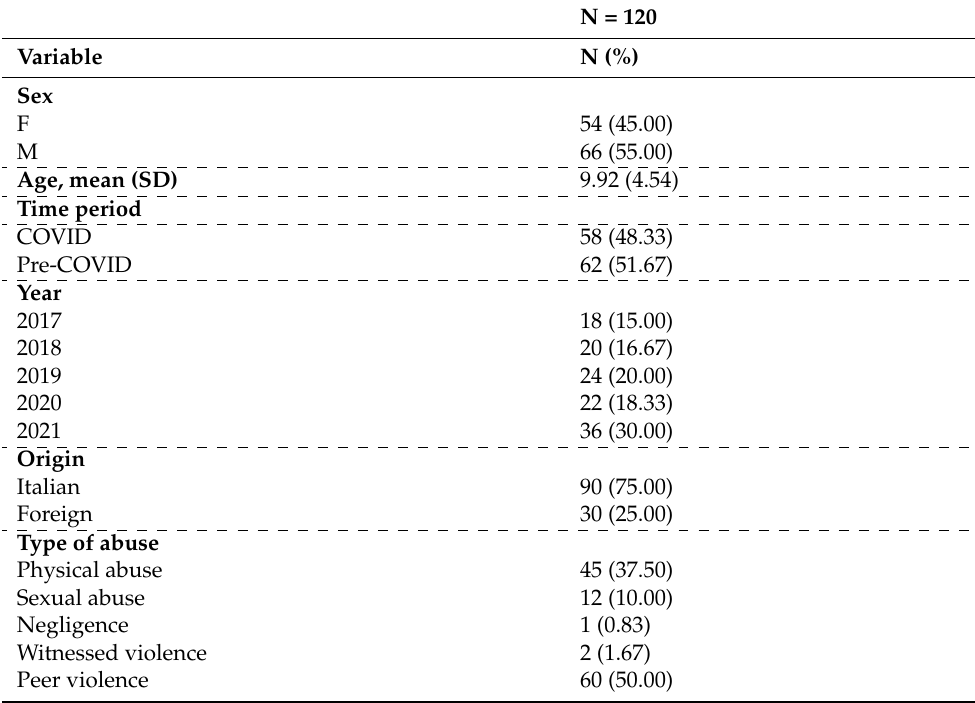
Table 1. Distribution of the minor’s characteristics.